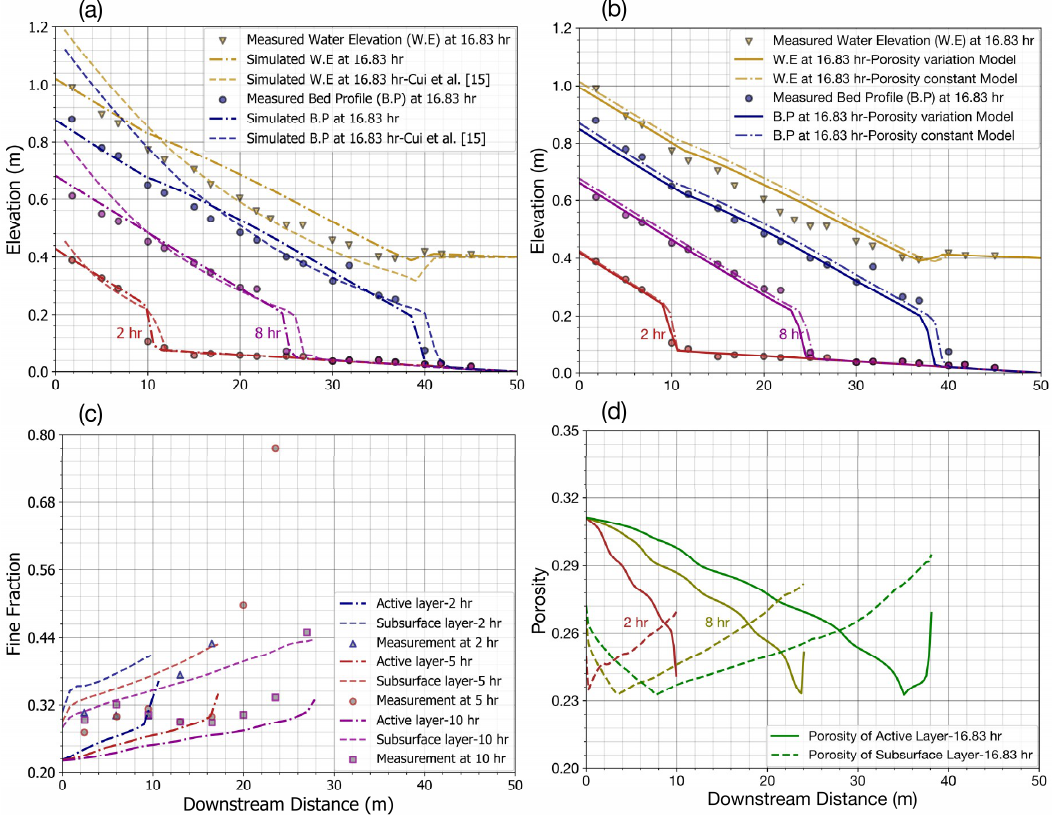
Figure 13. Simulated results in comparison with possible observations and Cui’s study [15]: ( a ) bed and water elevations obtained from constant porosity model; ( b ) bed and water elevations obtained from both constant and variable porosity models; ( c ) Sand fraction obtained from variable porosity model; and, ( d ) Calculated porosity variation. Table 5. Statistical performances of bed variation model in two layers.